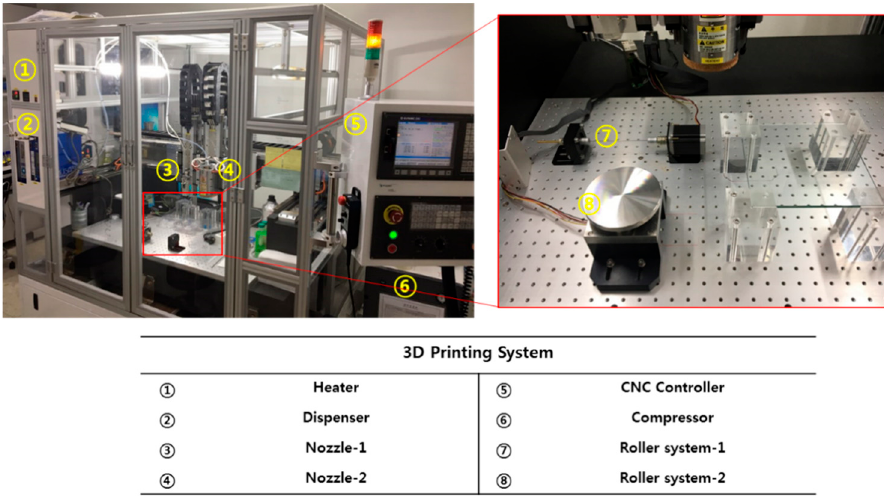
Figure 1. Configuration of the 3D printing system.